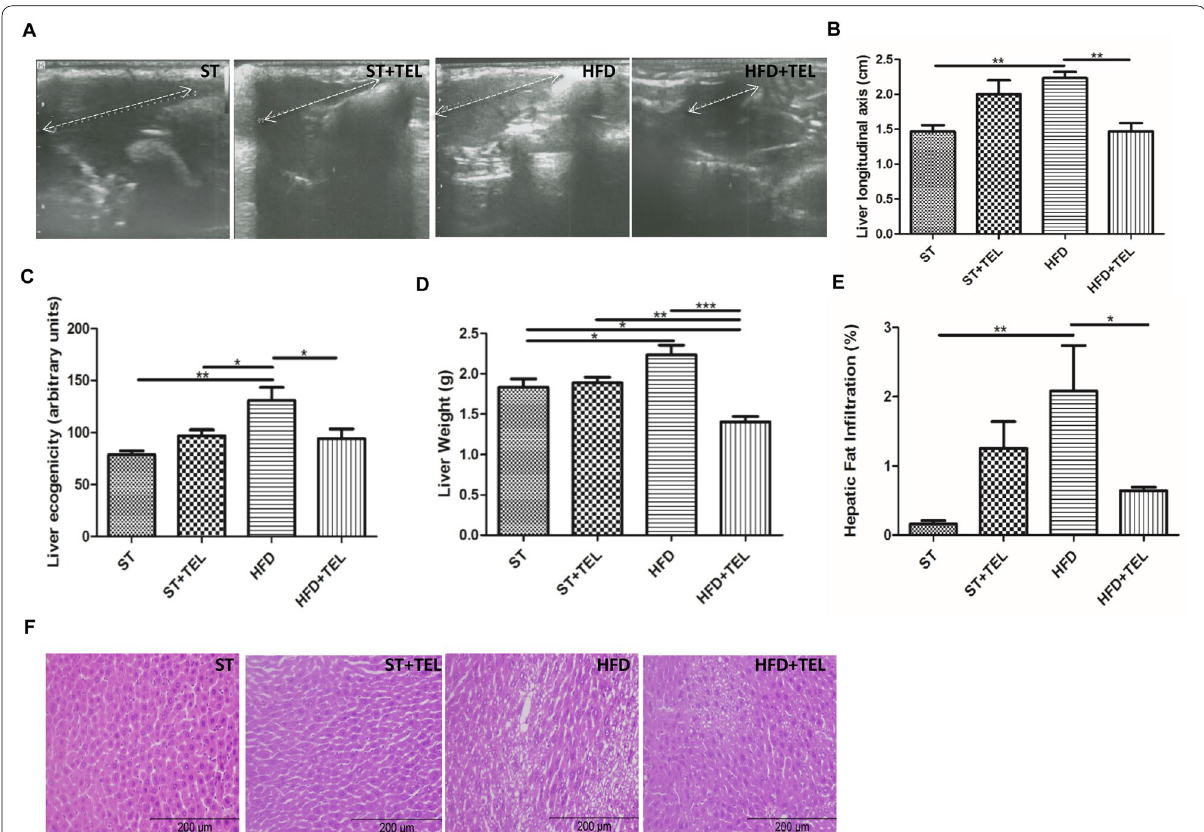
Fig. 4 Liver ultrasonography (US), weight, and hematoxylin/eosin staining in mice treated with Telmisartan and fed with a standard and high-fat diet (ST, ST TEL, HFD, HFD TEL). Scale bar, 200 μm. Liver US images ( a ), longitudinal axis measured by US ( b ), echogenicity ( c ), weight ( d ), fat + + infiltration ( e ), and hematoxylin/eosin staining ( f ). Arrows in A indicate the liver. Data are presented as the